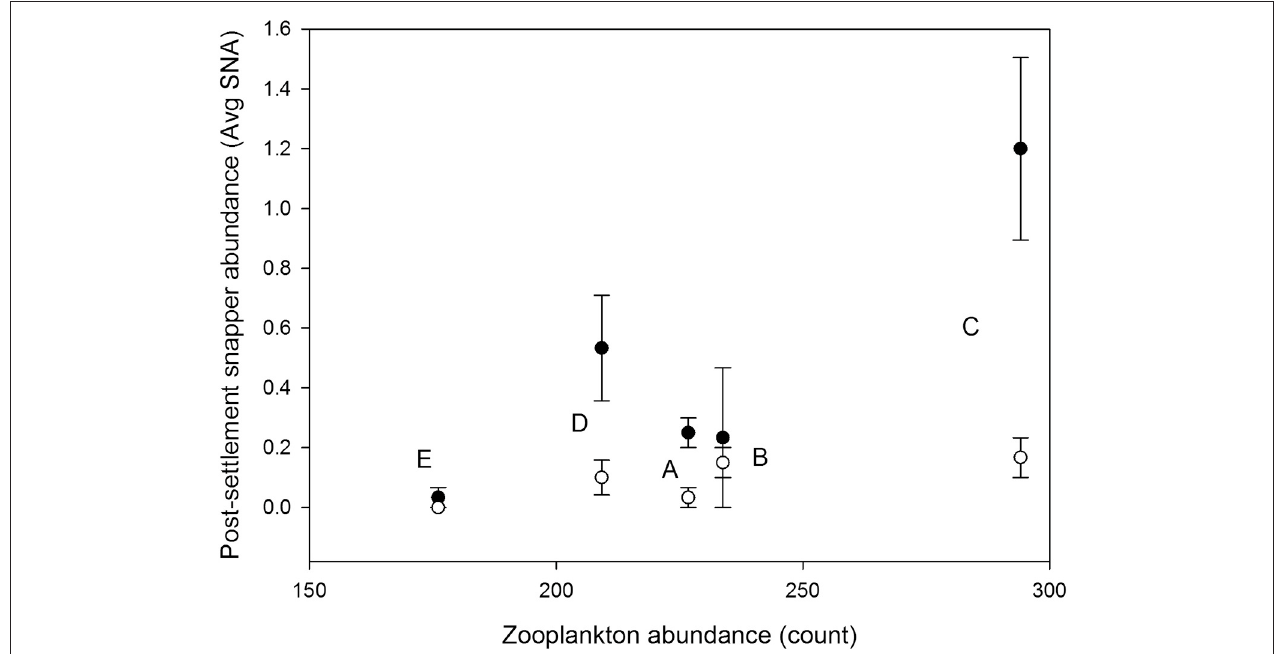
FIGURE 3 | Average abundance of post-settlement snapper (Avg SNA) in structured (filled circle) and control (i.e., unstructured, open circle) habitat patches at each of the five study sites (E, A, D, B, C; labeled next to relevant data points). Error bars are ± 1 standard error. The post-settlement snapper data are plotted vs. the average abundance of zooplankton items which dominate post-settlement snapper diet (calanoid and cyclopid copepods, and unidentified crustaceans) collected from near-bed bottom water at each site (see section Materials and Methods and Figure 4